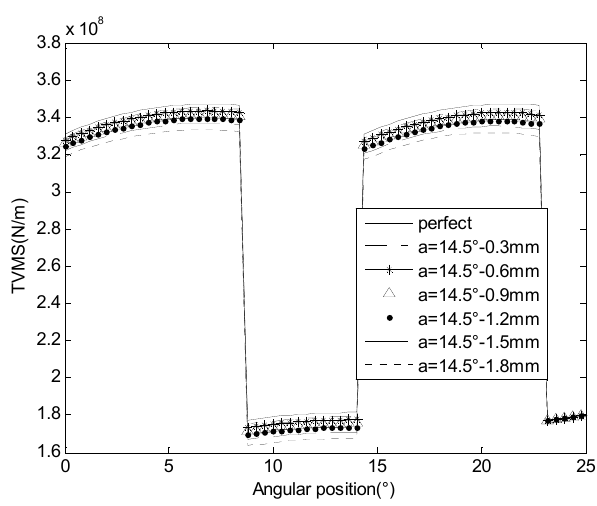
Figure 6. Gear tooth microcrack model.